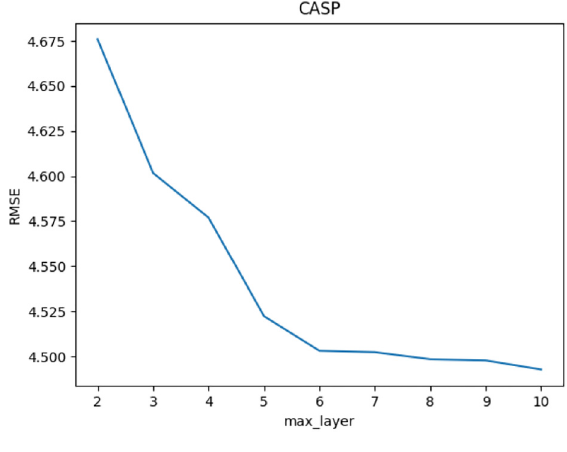
Figure 8. Relation between